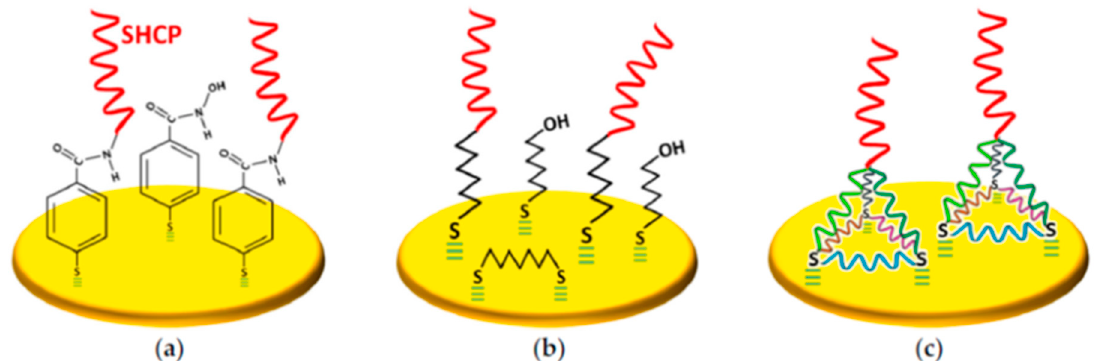
Figure 1. Schematic illustration of three di ff erent antifouling thiolated monolayers: ( a ) layers prepared by attaching NH 2 -CP to p-MBA SAM-modified electrodes, ( b ) ternary SHCP / HDT + MCH layers, and ( c ) layers prepared with TDNs. Reprinted from [29] with permission.